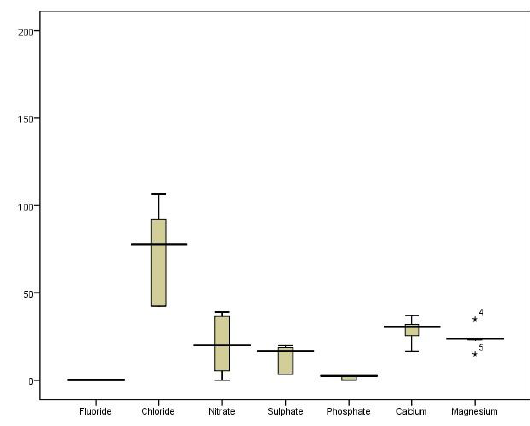
Figure 3. Box plot for